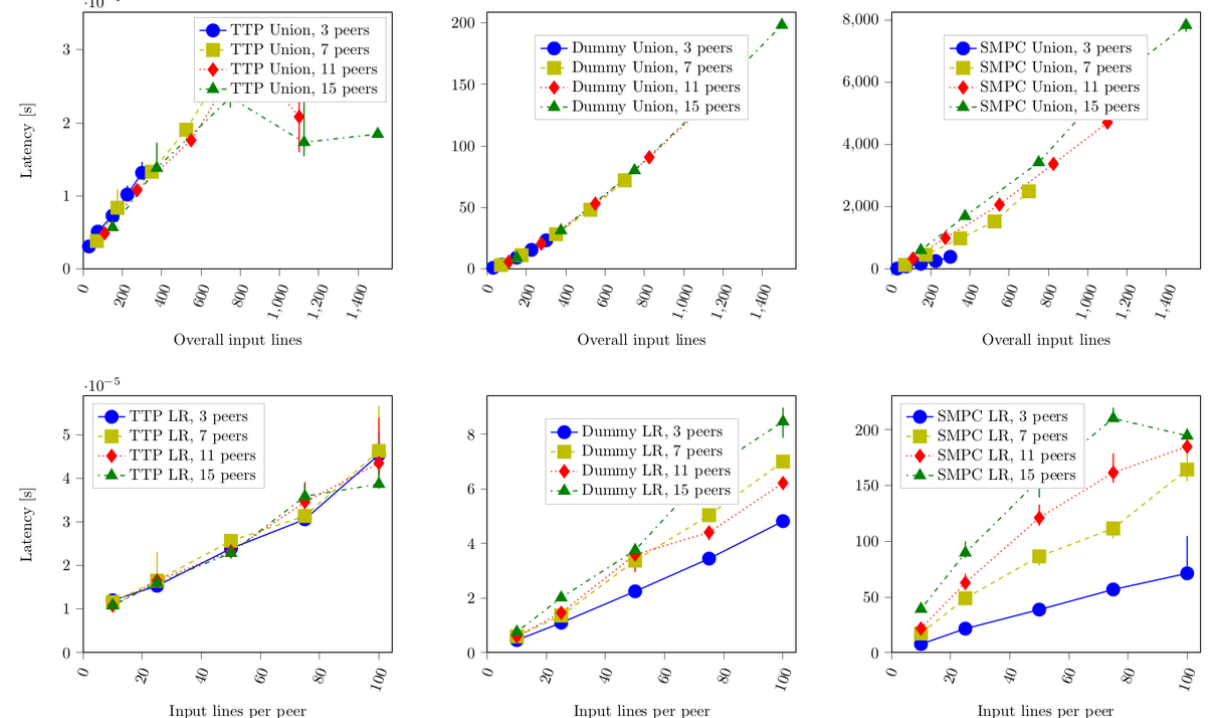
Figure 2. Measurements show that computation times of the corresponding algorithms on a trusted third party (TTP), a dummy implementation, and a real secure multiparty computation (SMPC) vary by orders of magnitudes, depending mainly on the overall number of input lines, with only a subordinate influence of the number of peers, since communication between peers can be parallelized. LR: